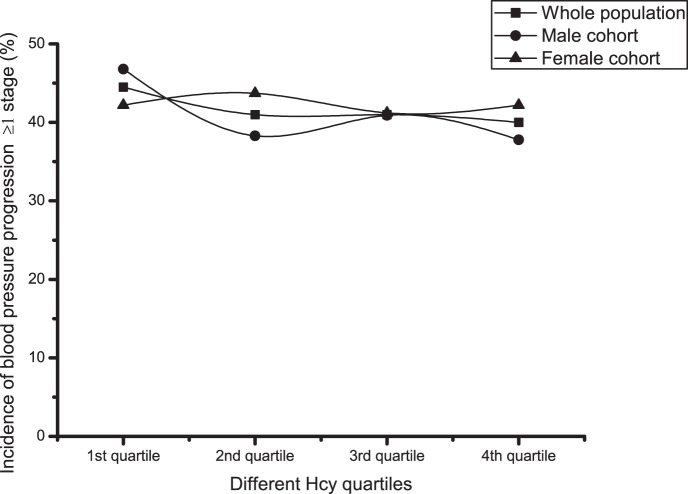
Blood pressure progression incidences within different Hcy quartiles.Square symbol: Whole population; Circle symbol: Male cohort; Up-triangle symbol: Female cohort.